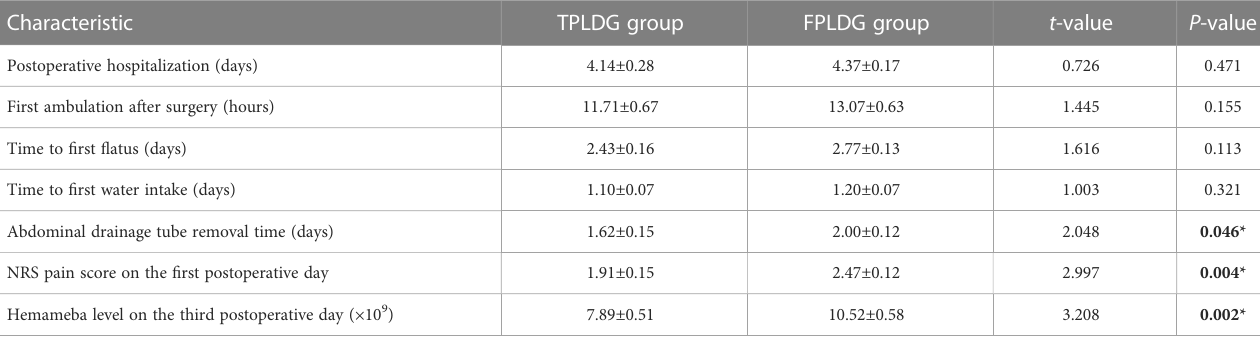
TABLE 4 Comparison of postoperative outcomes between the TPLDG and FPLDG groups.